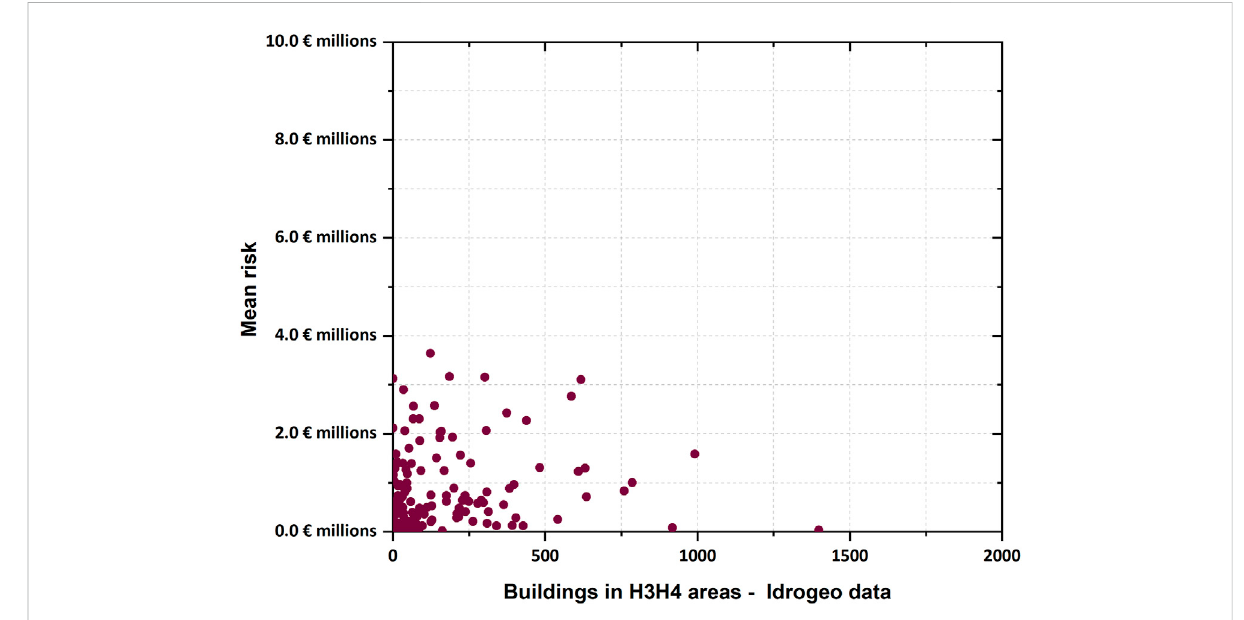
ISPRA data versus mean building